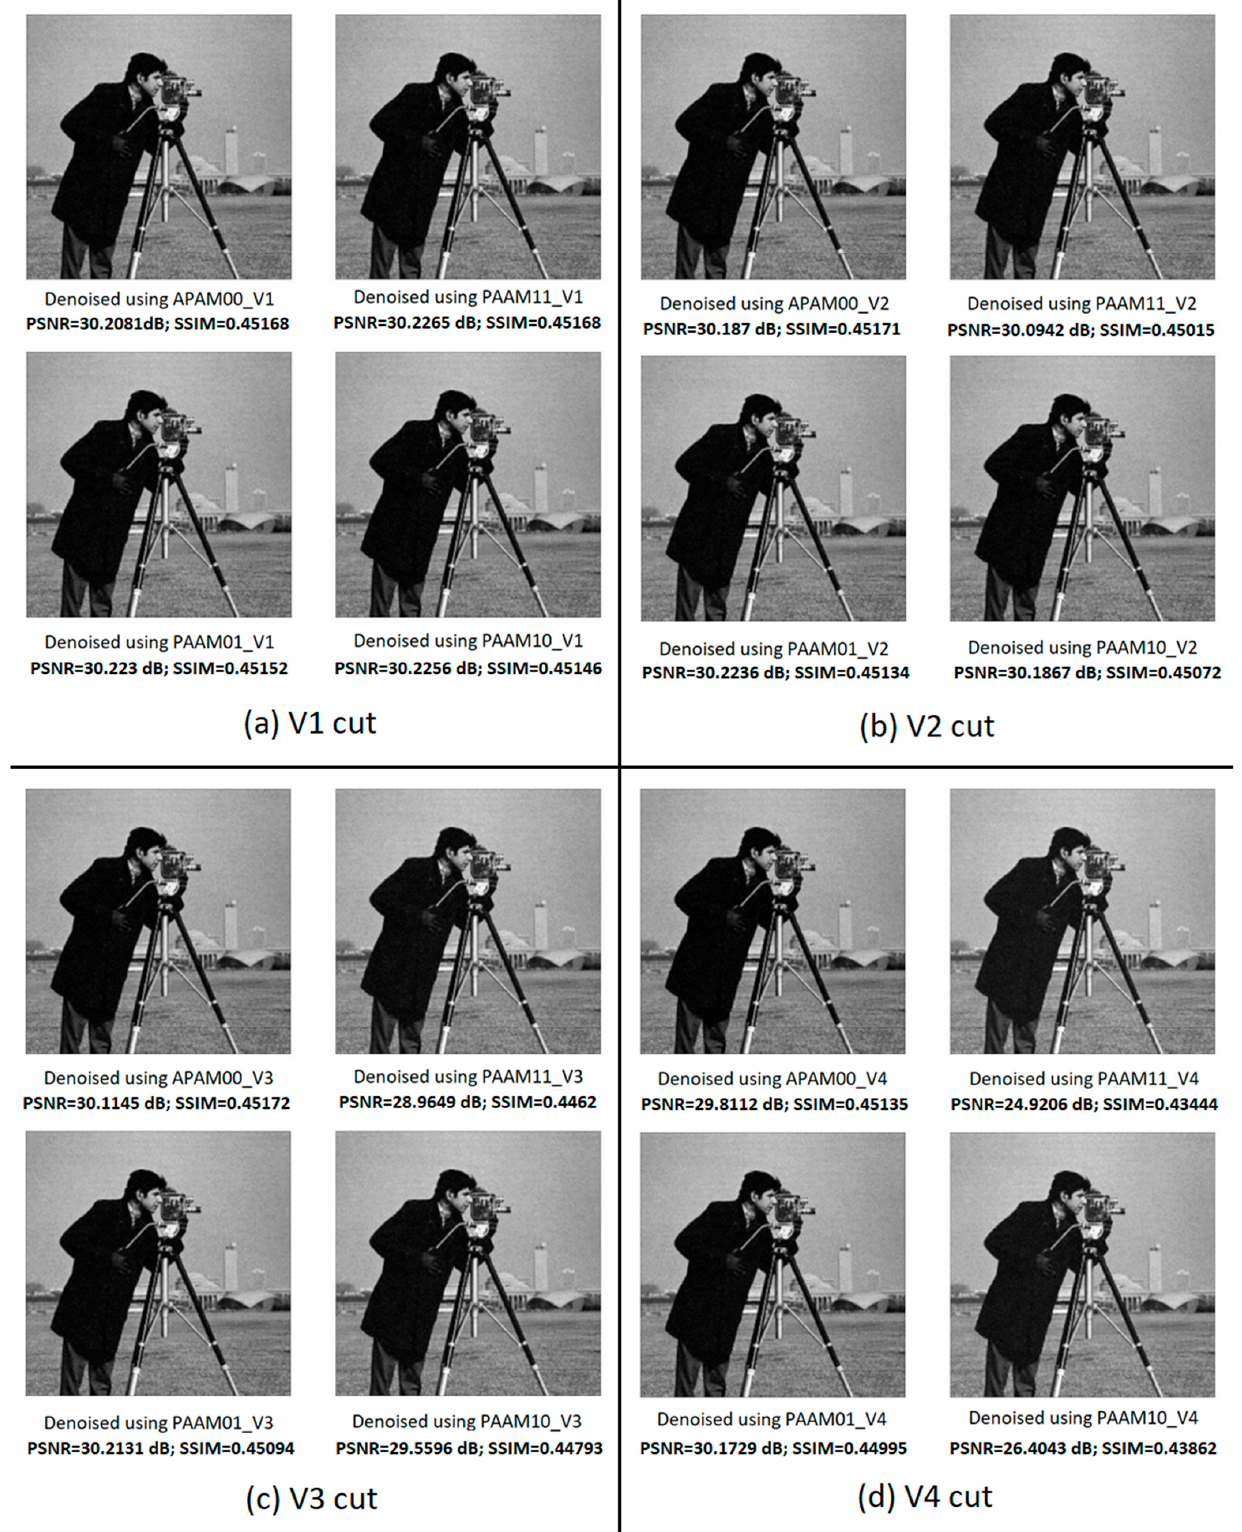
Figure 7. Denoised images obtained using approximate array multipliers resulting from: ( a ) V1 cut; ( b ) V2 cut; ( c ) V3 cut; and ( d ) V4